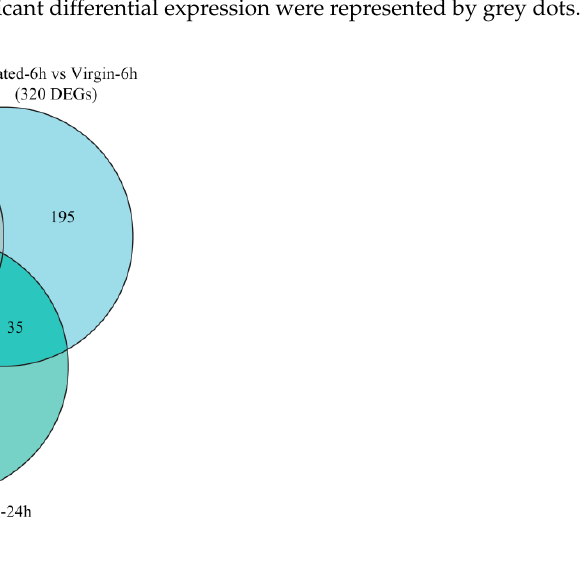
Figure 2. The Venn diagram of DEGs. The overlapping circles represented common DEGs among all combinations.